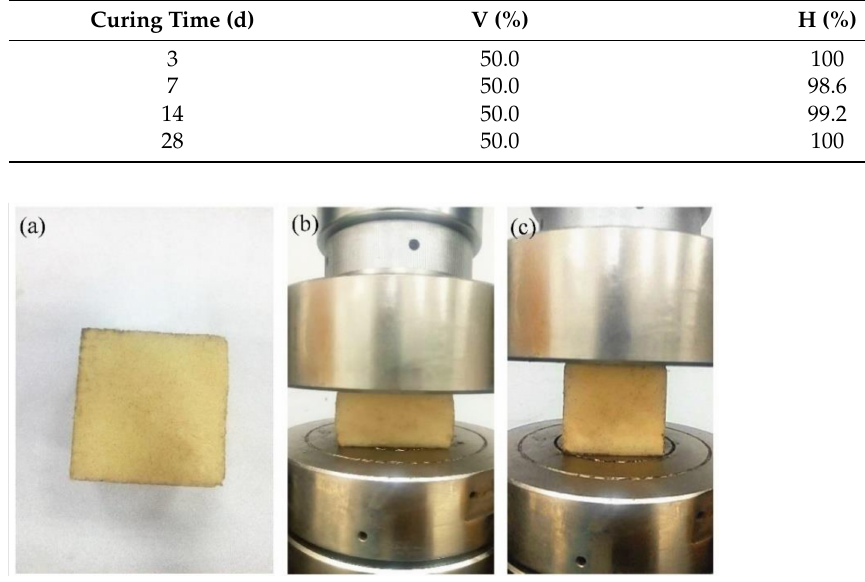
Figure 2. Testing process of compression and shape recovery (( a ). original sample; ( b ). compressed by 50%; ( c ). deformation